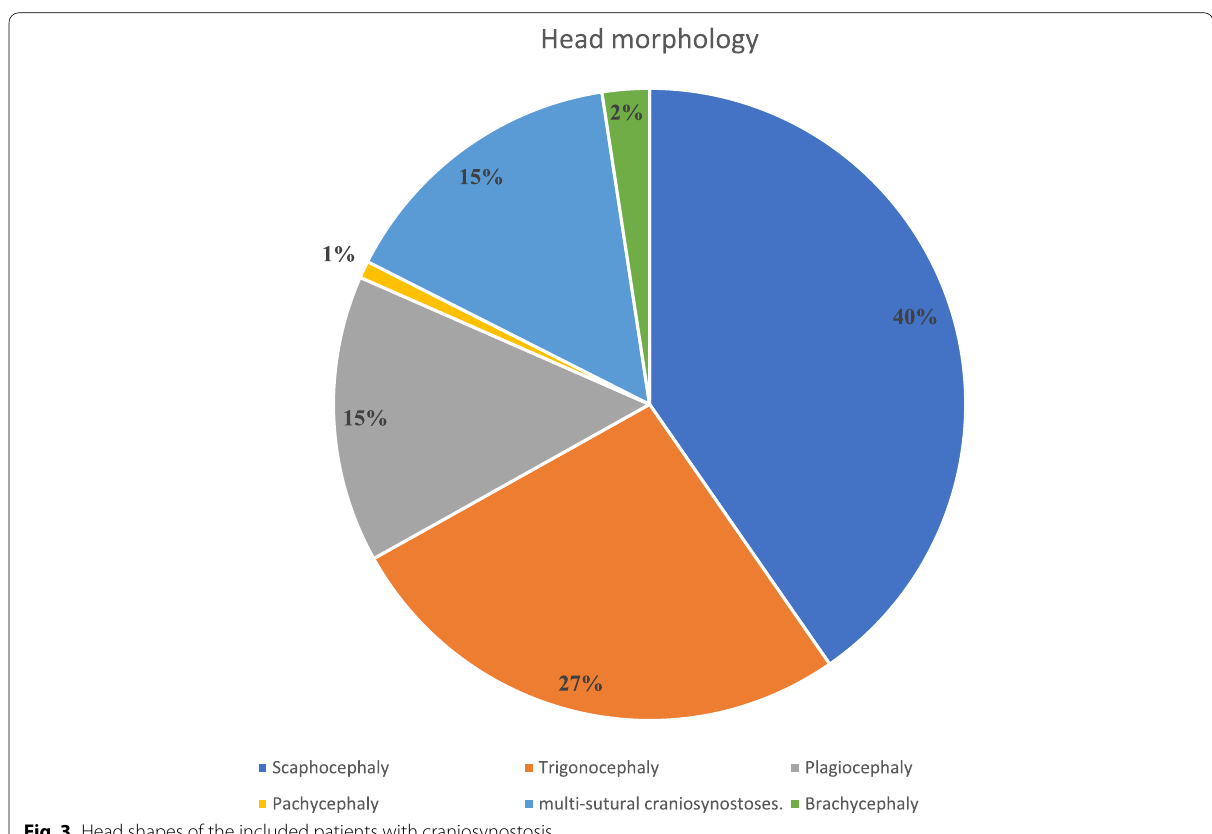
Fig. 3 Head shapes of the included patients with